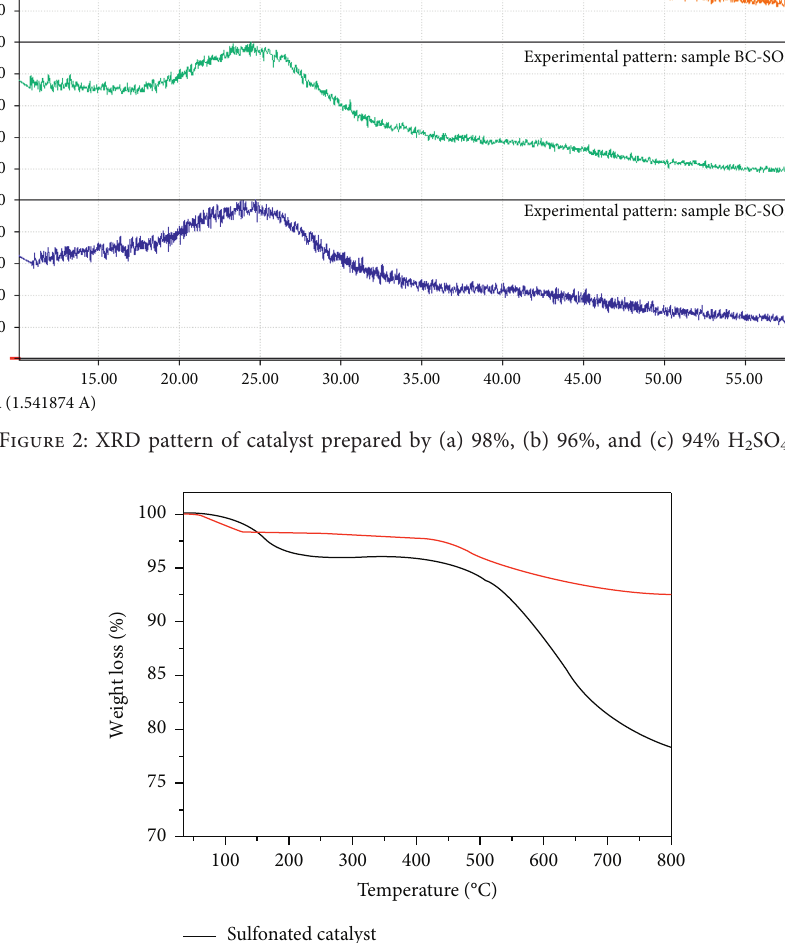
Figure 3: Thermogravimetric analysis (TGA) for catalyst from bamboo wood powder carbonized at 450 ° C BC-0 and after sulfonation (BC- SO 3 H − 1 ).